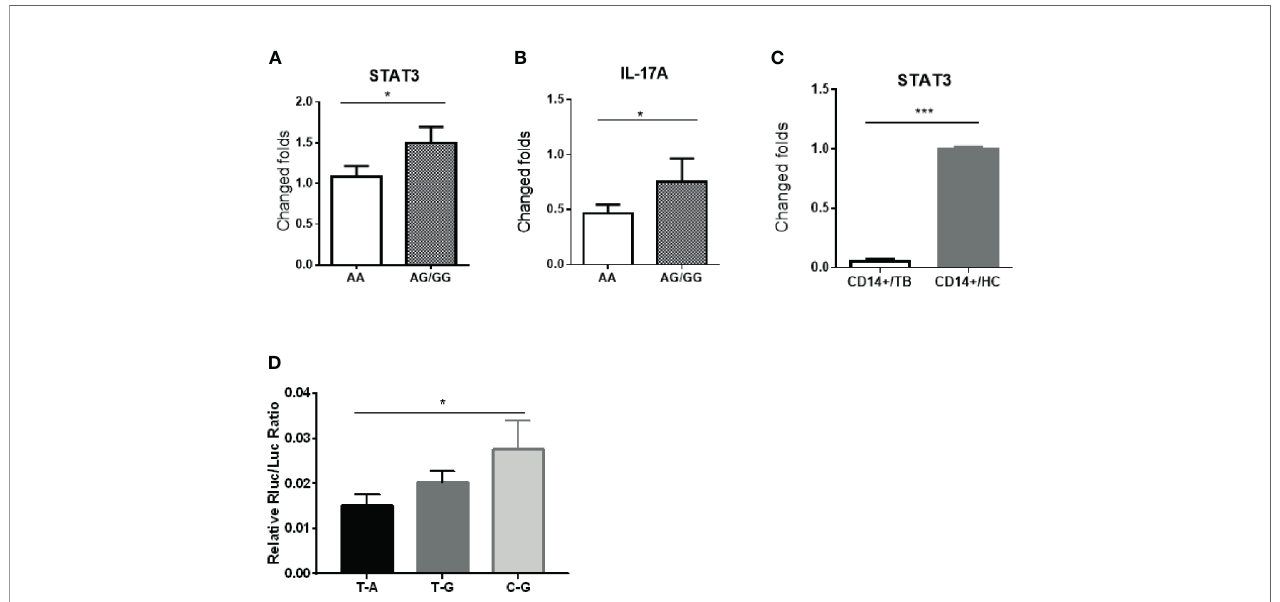
FIGURE 2 | The stat3 rs1053005 AA genotype coincided with the reduced constitutive expression of stat3 and IL-17A in PBMC, and the variant stat3 of rs1053004 – rs1053005 T-A haplotype indeed resulted in a reduced stat3 expression in reporter assays. Shown in (A, B) were expression levels of stat3 and IL-17A RNA, respectively, in PBMC of uninfected healthy control (HC) subjects expressing genotype AA (84 subjects) and AG or GG (AG/GG, 72 subjects). Stat3 and IL-17A RNA expressions were measured by qRT-PCR using PBMC freshly isolated from HC donors, and plotted as fold changes based on stat3 expression in genotype AA subjects. (C) shows comparative expression of stat3 RNA in CD14+ cells isolated from 30 HC subjects and 40 TB patients who were associated with the AA genotype or T-A haplotype. The stat3 expressions were measured by qRT-PCR and plotted as relative expression as described above. (D) shows that the variant stat3 of rs1053004 – rs1053005 T-A haplotype indeed resulted in a reduced stat3 expression in reporter assays. A luciferase encoding gene expression system was used to determine if the variant stat3 RNA of rs1053004 – rs1053005 T-A haplotype of stat3 3 ’ UTR could in fl uence the expression of stat3 itself. 293T cells were transformed with plasmids containing SNP rs1053004 – rs1053005 haplotypes T-A, T-G and C-G, respectively, and were tested for luciferase activity. Data are means ± standard errors. *P < 0.05 and ***P <